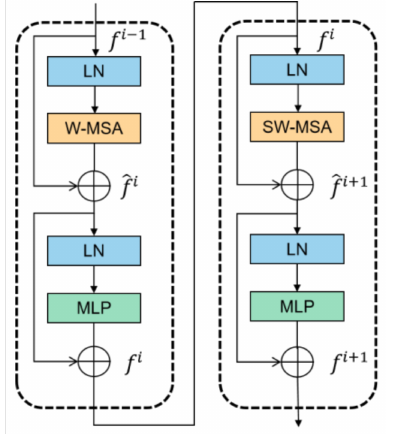
Figure 4. Swin transformer